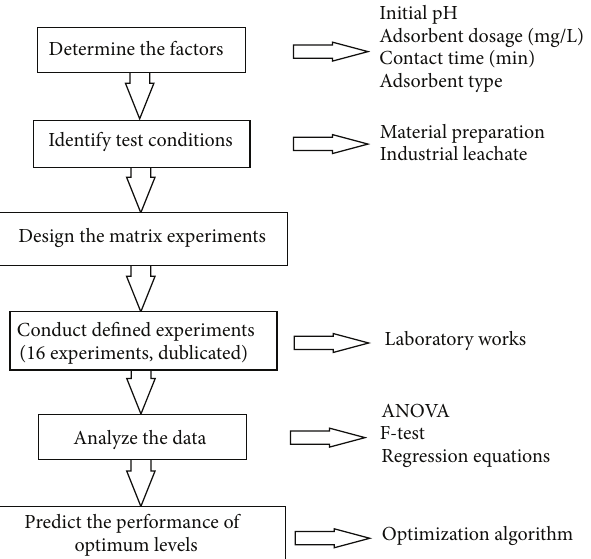
Figure 9: Cu(II) removal system based on statistical approach by montmorillonite.